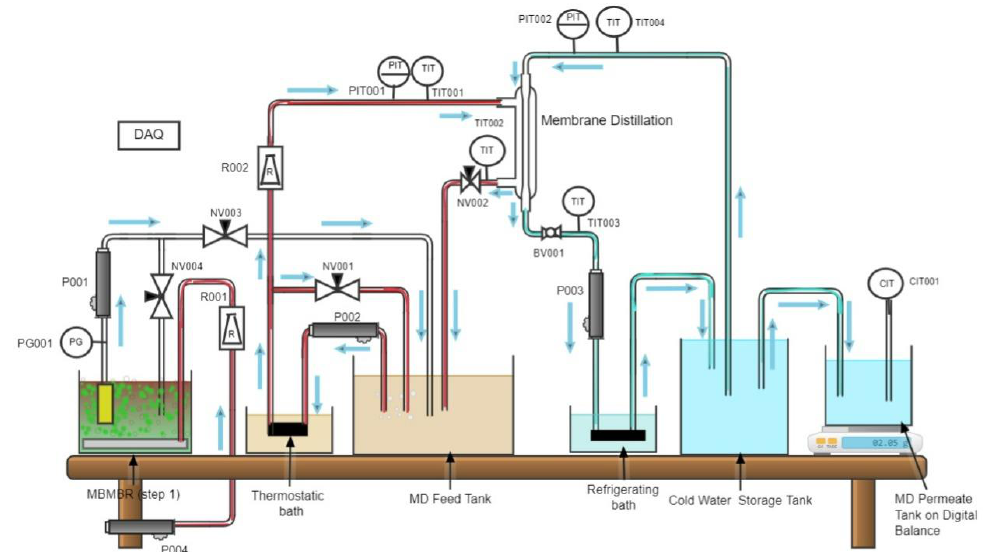
Figure 3. Schematic of the hybrid MBBMR and side stream DCMD configuration used in Experi-